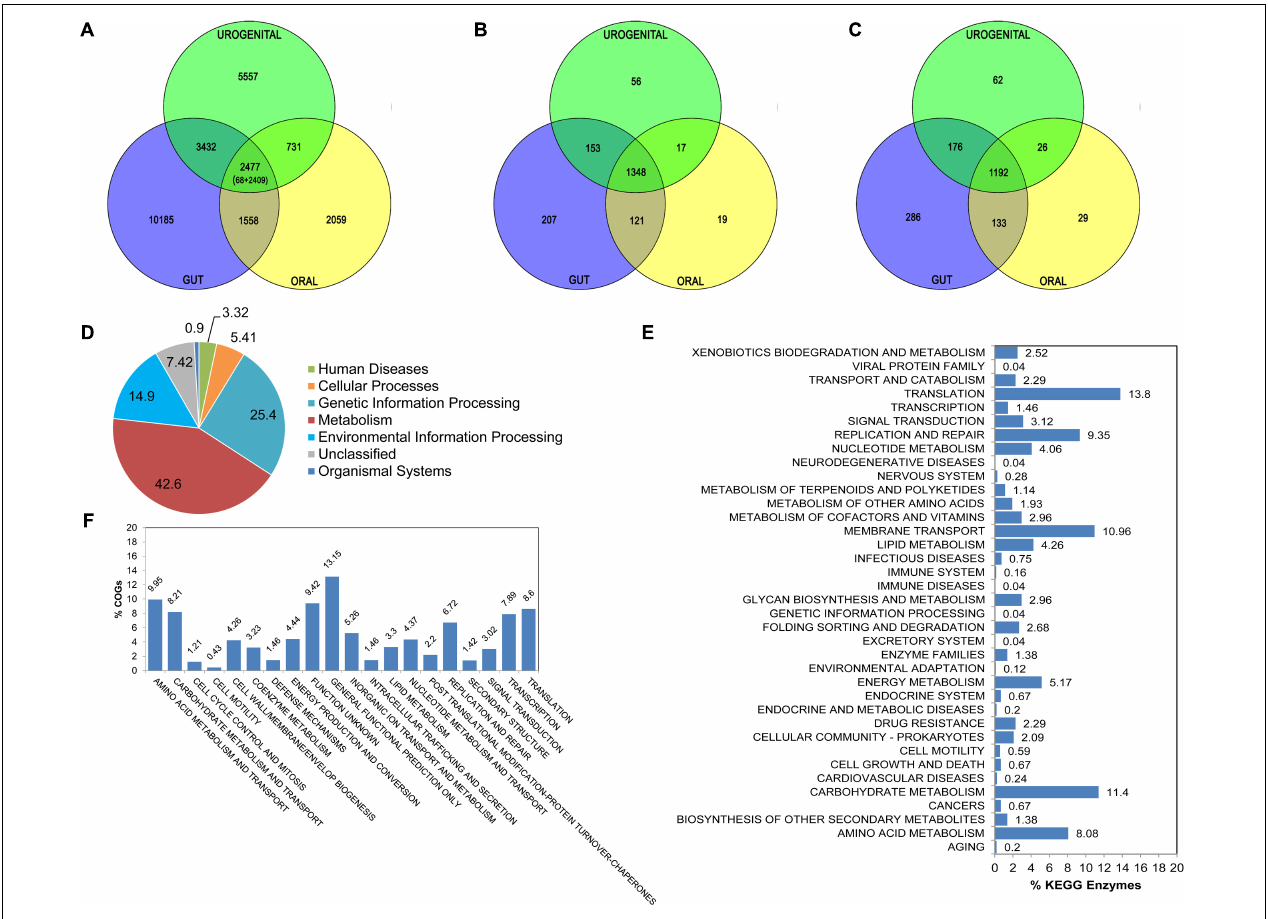
FIGURE 3 | Comparative analysis for Lactobacillus strains from gut, oral cavity and urogenital tracts. Venn diagrams depict the number of gene families (A) , COG proteins (B) and KEGG enzymes (C) at three body-sites. Distribution of major KEGG functional categories for 1192 core enzymes is shown as pie chart (D) . Bar plots are created in order to illustrate the distribution of detailed core functional KEGG enzymes (E) and COG proteins (F)